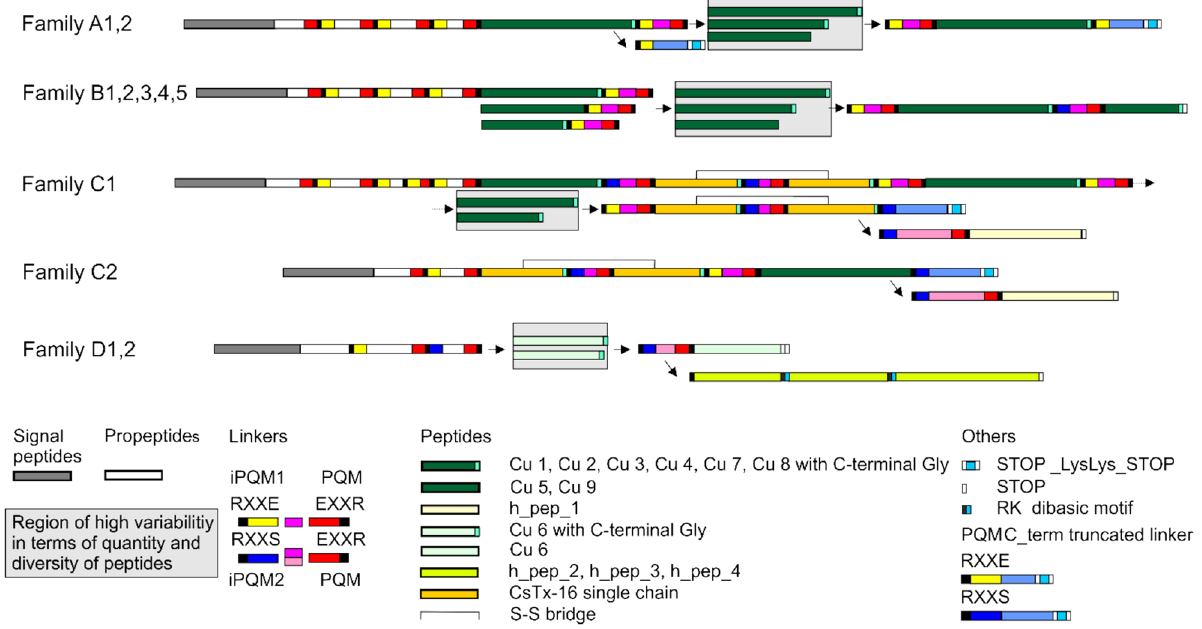
Figure 2. Overview on the construction of transcript families ( A – D ), encoding different LPs. Signal peptides, propeptides, and linkers, which are connecting different LPs, are illustrated as explained by symbols in the lower part of the figure. Likewise, differences in iPQM and PQMs structures, as well as in the C-terminus of the transcripts are colored corresponding to the symbol Signal peptides and propeptides. In general, transcripts encoding LPs are composed of short signal peptides followed by different propeptides and small LPs, which are separated by short, anionic amino acid residues. Such elements are defined as spacers or linkers and are characterized N-terminally by an inverted processing quadruplet motif (iPQM) and C-terminally by a processing quadruplet motif (PQM). Signal pep- tides are composed of 21 amino acid residues (transcripts A, B, C) or 20 amino acid residues (transcript D). The lengths of the anionic propeptides (theoretical pIs 3.85–4.33) vary between 25 and 42–49 amino acid residues and more than one third of them are Glu and Asp. The propeptides exhibit α-helical structures (28–70%) and dependent on their lengths, three to four PQMs and two to three iPQMs. Additionally, the C-terminal parts of the propeptides are used one to four times as linkers between the peptides within the corresponding transcript (transcripts A, B, C). Interestingly, on protein level, transcript B and C1 exhibit identical signal peptides and dif- fer from the signal peptide of transcript C2 in only one amino acid residue and from transcript A in three amino acid residues. Propeptides of all four transcript families exhibit major differences in amino acid composition and length (S1A-E Fig). Linkers. All LPs from C. salei are separated by linkers within the corresponding transcript. For data analysis, a linker is defined as a short amino acid sequence starting and ending with Arg and exhibiting both, iPQM and PQM. However, posttranslational processing by proteases will occur always after Arg and the remaining C-ter- minal Arg of the foregoing peptide and of the linker will be removed by a so far unknown Arg-C proteinase 17 . Linkers are mainly transcript family specific, even though the linker RTENEIDEEDER belongs to the C-ter- minal part of propeptides A2 as well as B2 and links different peptides: Cu 1a with Cu 4c (transcript A) as well as Cu 8 with Cu 3d, Cu 3d with Cu 4a, Cu 4e with Cu 4a, and Cu 4f with Cu 1a (transcript B). All linkers within transcript A (n = 18) and B (n = 10) are composed of 12 amino acid residues and exhibit at least one Glu in the iPQM (iPQM1 variant) and in the PQM. Characteristic are molecular masses around 1529 Da, and a mean anionic pI of 4.08, which is caused by five to seven Glu/Asp residues per linker. Nearly half of the linkers of transcript C1 and C2 are composed of 11 amino acid residues and the N-terminal iPQM possesses no Glu residue but a Ser residue (iPQM2 variant). Such linkers are identified only before and between CsTx-16 single peptide chains (n = 3). The mean molecular mass is 1284 Da and these linkers exhibit a higher pI (4.44) due to less Glu/Asp in its sequences. Remarkably, in transcript C2 one linker, which is composed of 13 amino residues, was identified and also confirmed by NGS. Also, all linkers of transcript D peptides exhibit 13 amino acid residues, and show structurally only few differences. Six main linkers connect the most diverse members of the LP family Cu 6. Comparable to some transcript C linkers, the N-terminal Glu is replaced by a Ser and a Thr residue. In total, we identified a minimum of 43 different linker sequences by 454-seq, responsible for the arrangement of different LPs in different transcripts (Table 1).